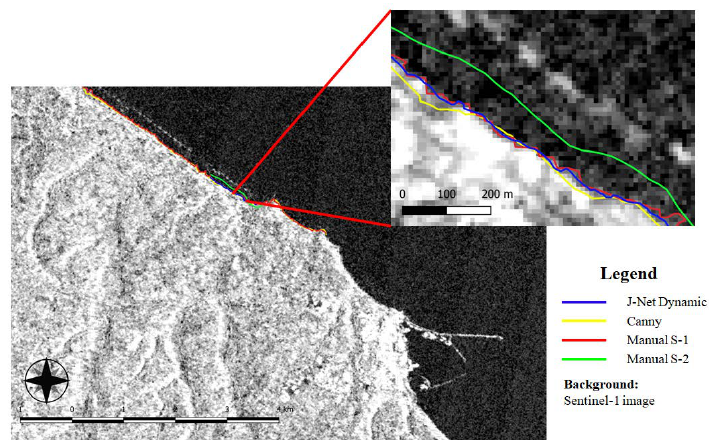
Figure 7. SAR Sentinel-1 image on the background showing four shorelines: the red and the green lines are, respectively, the shorelines manually extracted from Sentinel-1 and Sentinel-2 images; the yellow one is the one generated using the Canny algorithm and the blue one from the J-Net Dynamic